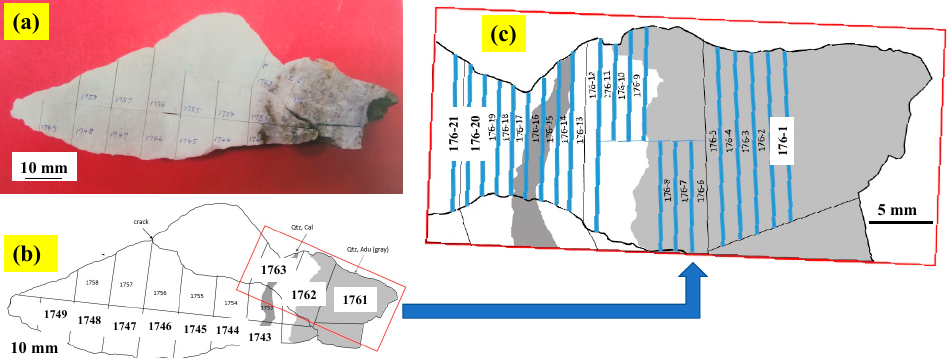
Figure 4. ( a ) Photo for the 20100317 high-grade vein sample taken from the 25 mL KE-3-1 vein. The vein width is about 50 cm. The right end of the vein is adjacent to the wall rock, and the left is around the center of the vein. In the early stage of mineralization, the gray part contains fine-grained pyrite and clay minerals. The calcite-bearing samples covering early to late mineralization are rare in the Hishikari deposit. ( b ) The vein sample 20100317 is cut every 10 mm in the growing direction, and every sample is numbered. The rectangle shows the area for Figure 3c. ( c ) Sections measuring 0.9 mm-width are made from 1761, 1762, and 1763 samples, numbered from 176–1 to 176–21. Blue lines designate areas cut off with a 0.3 mm thick blade. The 12 μ m-width powder samples for microanalysis are scraped from 176–20 and 176–21 sections. Table 2. Mineral composition and isotope data of calcite-bearing 20100317 vein sample (10 mm- width sample set; Figure 4b) from 25mL E60 KE-3-1E.